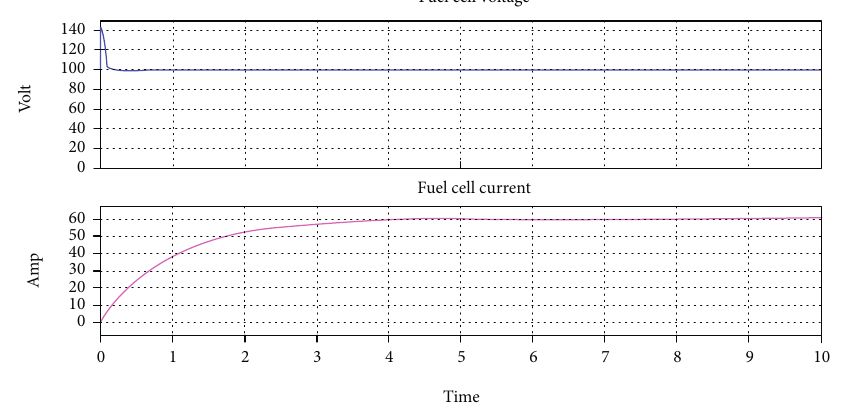
Figure 20: Fuel cell voltage and current